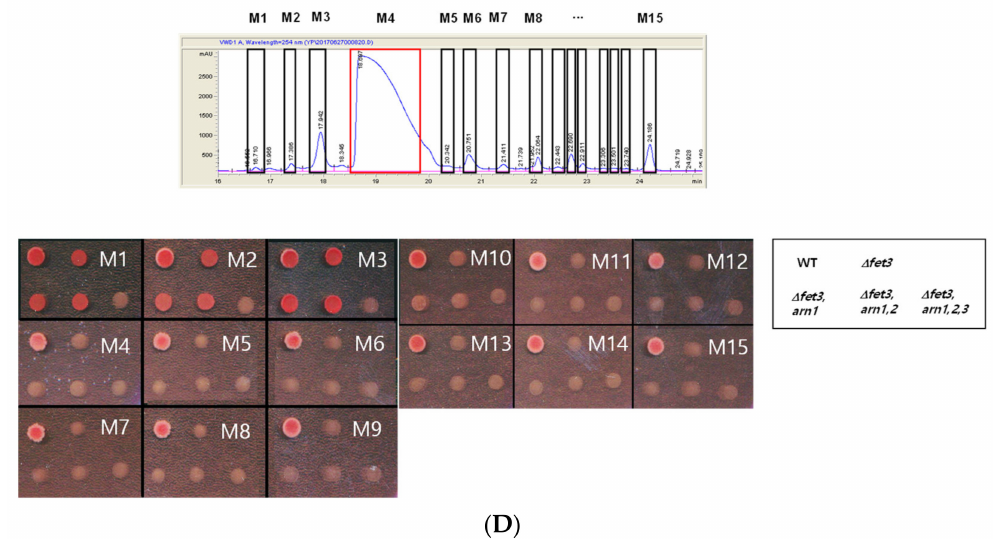
Figure 2. HPLC analysis and purification of functional molecules from P. eryngii. ( A ) The eluates of the XAD-16 column of the ethanol extract were separated by HPLC analysis into four fractions, F1, F2, F3, and F4. Then, each fraction was subjected to a plate assay to identify the fraction with ferrichrome. The genotype indicates the deletion mutant, as described in the Materials and Methods. Additionally, the plates used in this experiment are low iron media containing 10 mM iron and BPS. ( B ) The F2 fraction was separated further into five fractions: F2P1, F2P2, F2P3, F2P4, and F2P5. Each fraction was subjected to a plate assay to identify the fraction that had ferrichrome. ( C ) Additionally, the F2P1 fraction was separated into three fractions: F2P1R1, F2P1R2, and F2P1R3. Each fraction was subjected to a plate assay to identify the fraction that had ferrichrome. ( D ) Finally, the F2P1R2 fraction was separated into 15 fractions that showed well-isolated peaks, and each fraction was subjected to a plate assay to identify the fraction that had ferrichrome. The yeast genotypes inside the circle and square of C and D indicate the yeast strains used in this